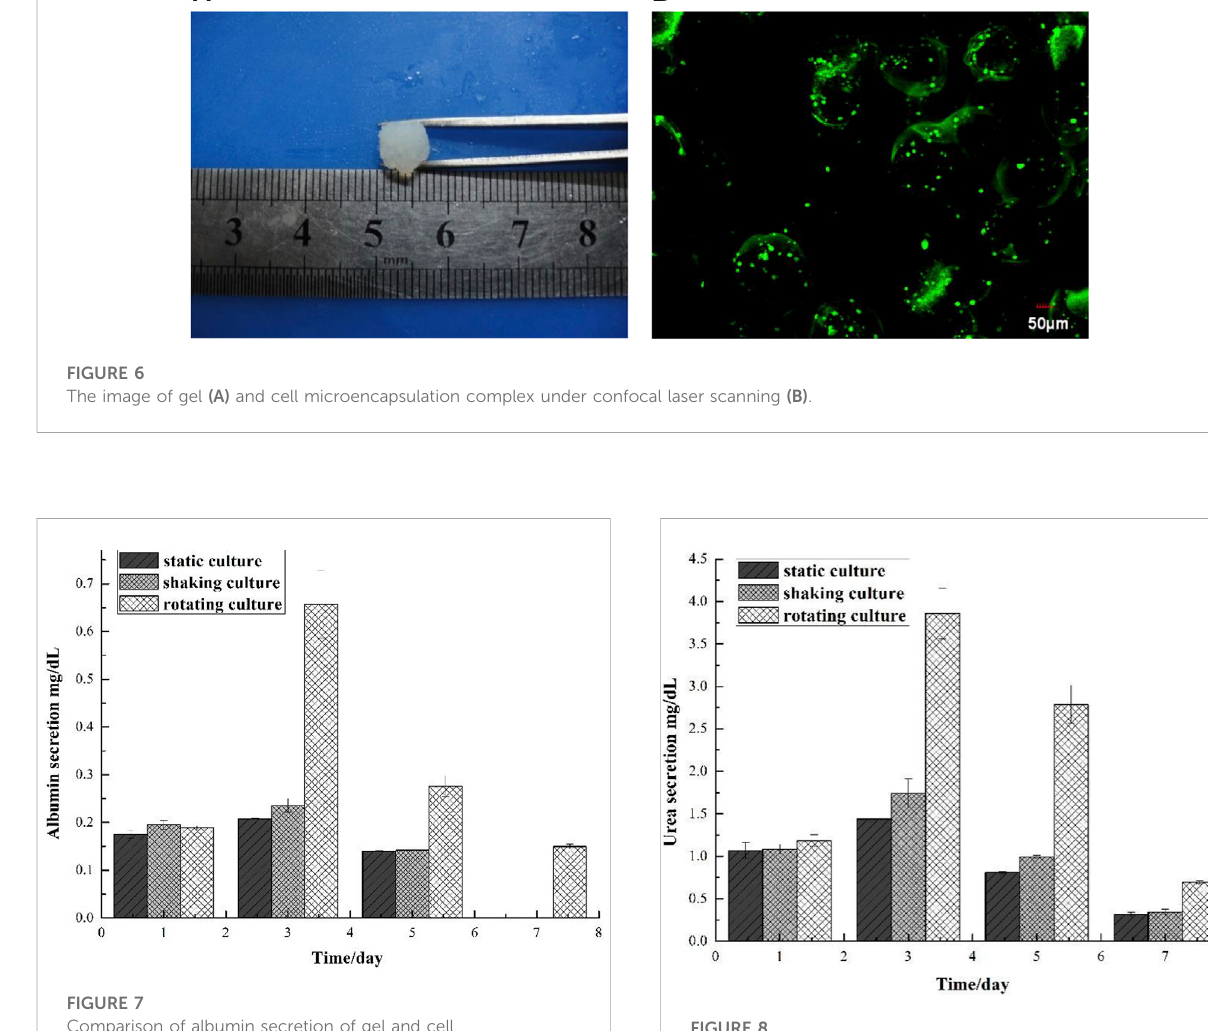
FIGURE 8 Comparison of urea secretion of gel and cell microcapsulation composites in different culture